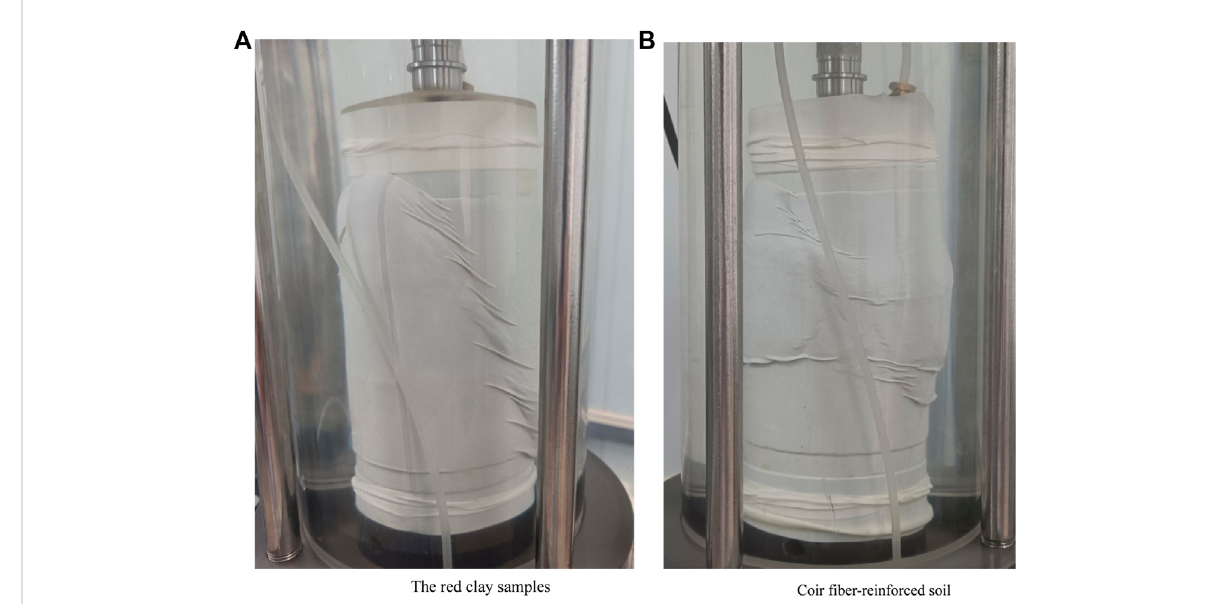
FIGURE 3 Mode of sample failure. (A) The red clay samples, (B) Coir fi ber-reinforced soil.